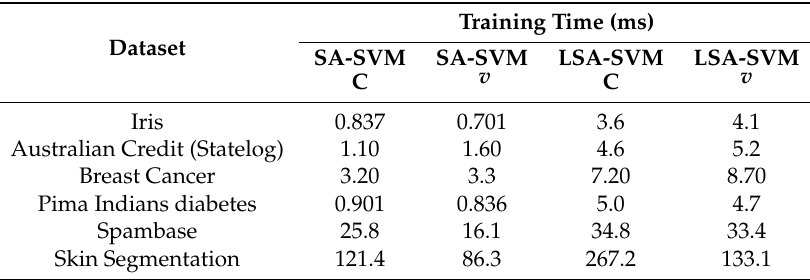
Figure 16. The training time consumption for each type of classifier. Table 9. The training time consumption for each type of